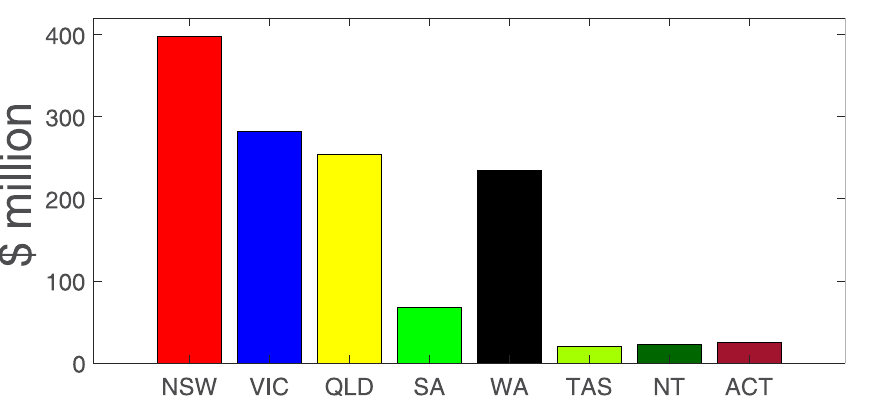
Fig 6. Cost of COVID control measures by region ($million/day). Note: NSW = New South Wales; VIC = Victoria; SA = South Australia; WA = Western Australia; TAS = Tasmania; NT = Northern Territory; ACT = Australian Capital